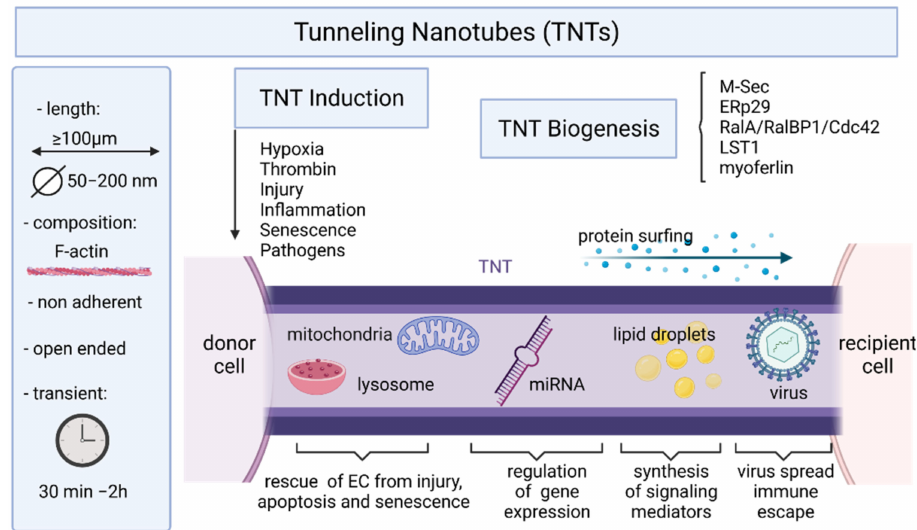
Figure 2. A schematic overview of TNT major characteristics and cargoes. Conditions inducing TNT formation and molecules implicated in TNT biogenesis are